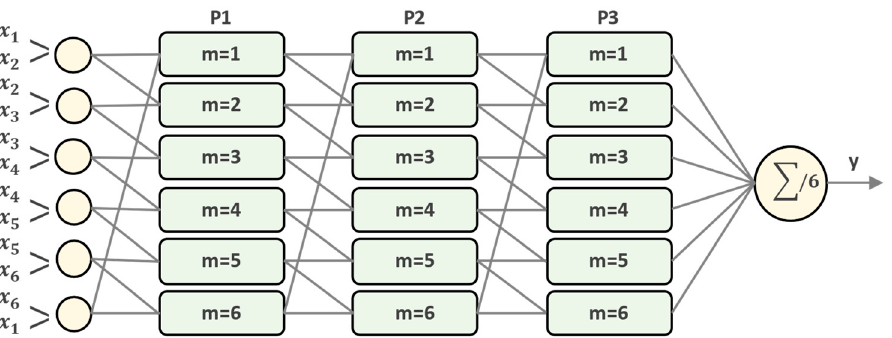
Figure 4. The hybrid structure of the Fuzzy GMDH model.